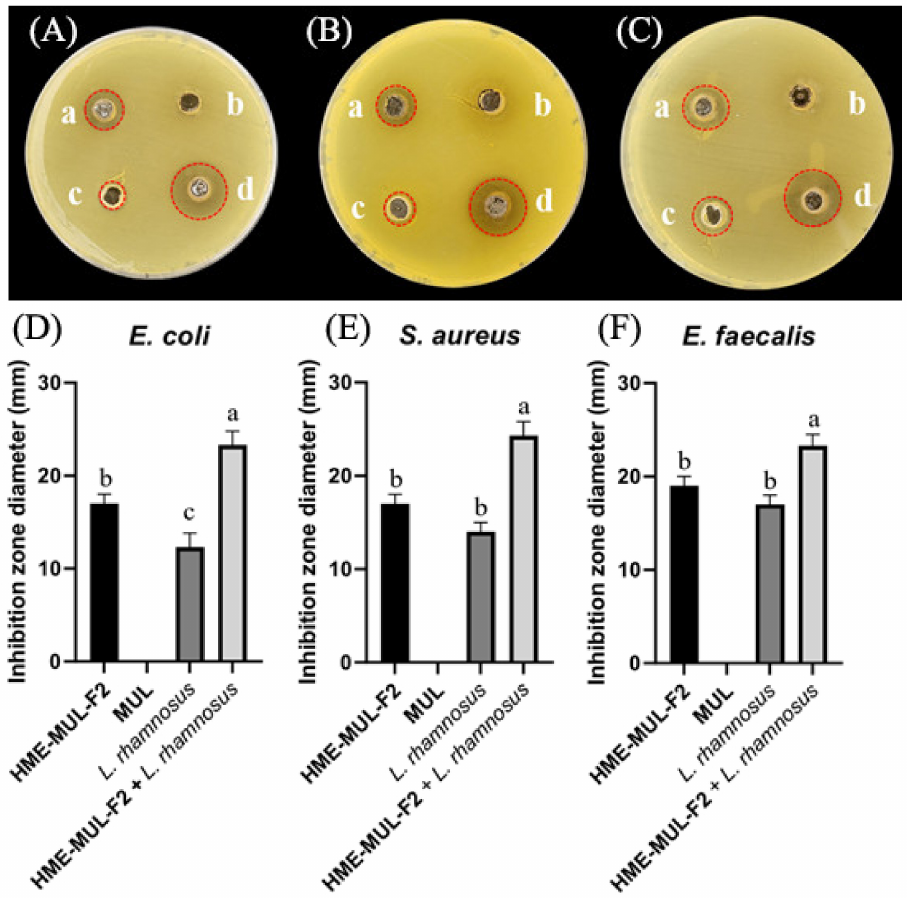
Figure 10. Inhibition zones in the presence of lactic acid bacterial probiotic L. rhamnosus against test pathogens after treatment with HME-DDS formulation (HME-MUL-F2). ( A , D ): Inhibition against E. coli . ( B , E ): Inhibition against S. aureus. (C) and (F): Inhibition against E. faecalis . a: treatment with HME-MUL-F2, b: treatment with MUL, c: treatment with L. rhamnosus only, d: treatment with L. rhamnosus + HME-MUL-F2. ( A – C ) Photos of clear zone in the presence of probiotics, HME-MUL-F2, and MUL. ( D – F ) Quantification of inhibition zone diameter in the presence of MUL, HME-MUL- F2, probiotics only, and probiotics + HME-MUL-F2, respectively. a,b value differences in the same condition ( p < 0.05). Data are presented as mean ± SD ( n = 3).When L. rhamnosus cell suspension alone was used as treatment against pathogenic bacteria E. coli , S. aureus , and E. faecalis , diameters of growth inhibition zones were 13.0 ± 1.0 mm, 18.0 ± 1.0 mm, and 14.0 ± 1.2 mm, respectively. However, when cell suspension of P. pentosaceus in combination with HME-MUL-F2 was used as treatment, diameters of growth inhibition zones were 23.0 ± 1.0 mm, 23.3 ± 1.5 mm, and 22.0 ± 1.5 mm, respectively (Figure